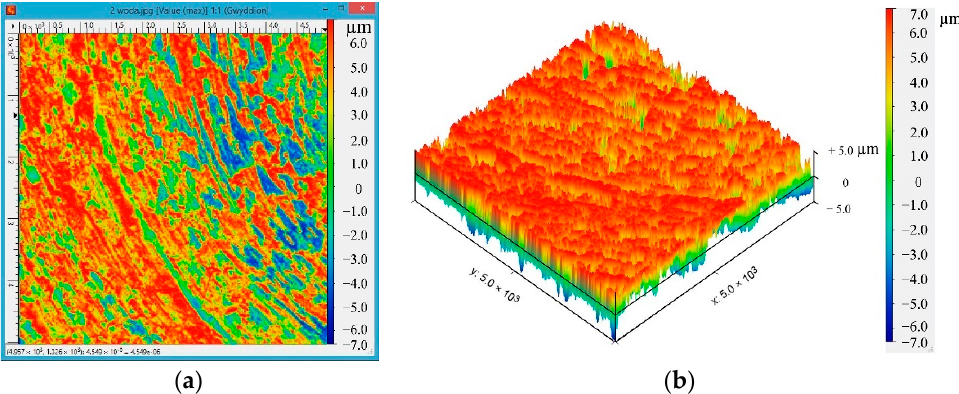
Figure 8. Cutting surfaces of 38KHN3MFA steel samples with water: 2D visualization ( a ) and 3D visualization ( b ) in the Gwyddion computer package.